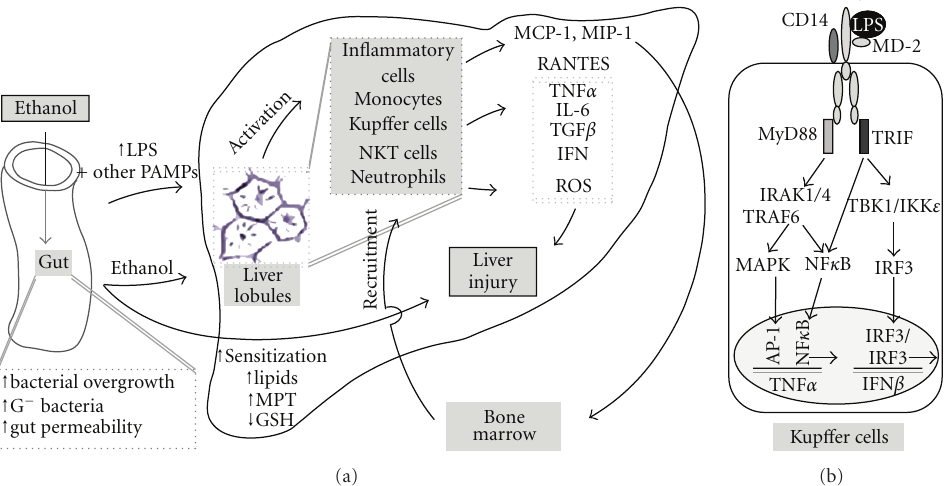
Figure 1: Pathophysiology of alcohol-induced liver injury. (a) Ethanol promotes translocation of LPS and other pathogen-associated molecular patterns (PAMPs) from the gut to the portal vein and to the liver. In the liver, LPS induces activation and recruitment of bone marrow-derived inflammatory cells. Activated bone marrow-derived cells synthesize inflammatory cytokines and reactive oxygen species that induce liver injury. Chronic ethanol per se contributes to sensitization of monocytes/macrophages to LPS and to sensitization of hepatocytes to the cytotoxic e ff ect of inflammatory cytokines. The latter is brought about by accumulation of lipids, opening of mitochondrial permeability transition (MPT) pores, and depletion of glutathione (GSH). (b) In macrophages/Kup ff er cells, TLR4 recognizes LPS in cooperation with its coreceptors, CD14 and MD-2. The signal is passed through MyD88-dependent or TRIF-dependent intracellular pathways, which activate various transcription factors, including AP-1, NF κ B, and IRF3, and induces proinflammatory cytokine and Type I interferon